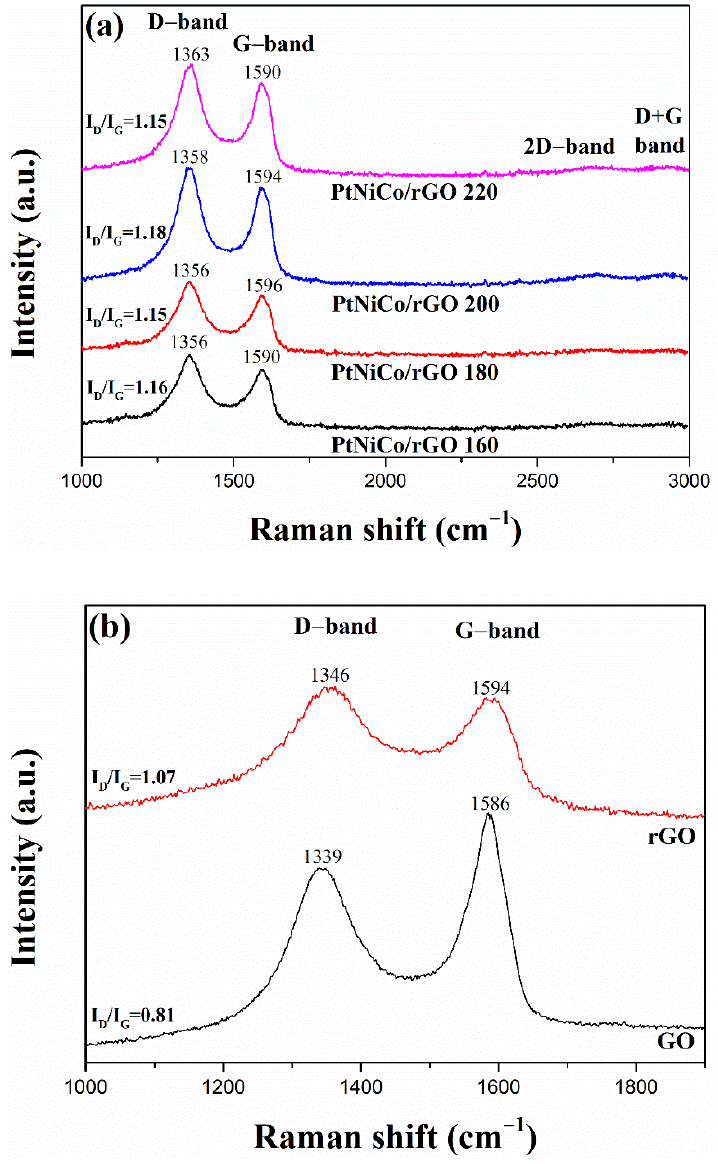
Figure 6. Raman spectra of ( a ) PtNiCo/rGO at various temperatures. ( b ) GO and rGO. The I D /I G value of PtNiCo/rGO is higher than that of GO, indicating that the double bond of GO is broken and composited with metal nanoparticles. The larger the I D /I G value,